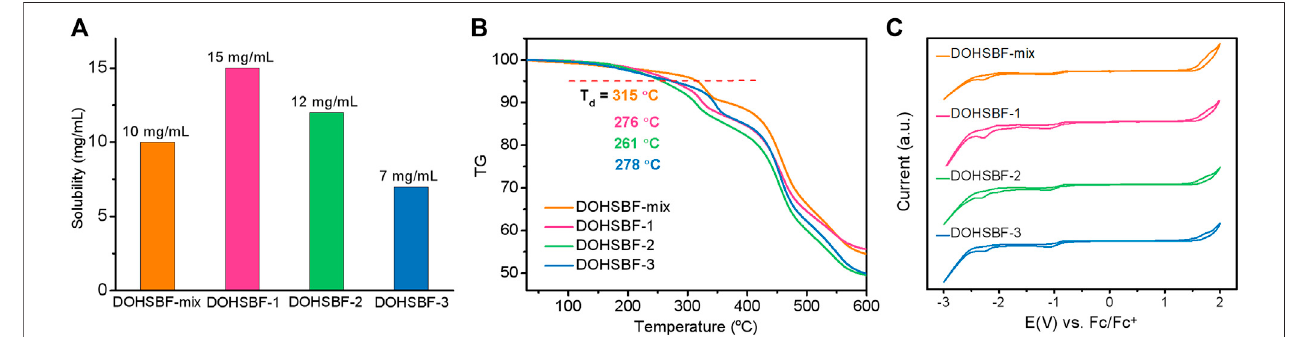
FIGURE 3 | (A) The solubility of DOHSBF in dichloromethane. (B) TGA curves and (C) cyclic voltammogram of DOHSBF.